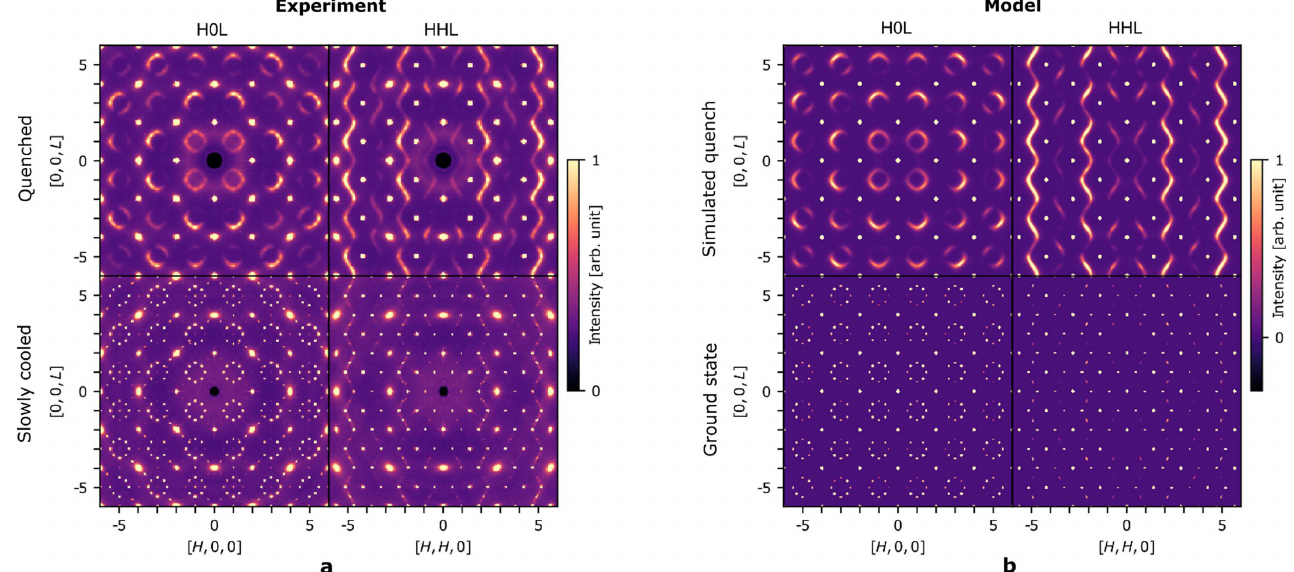
Figure 2 Measured and calculated X-ray scattering in the H0L and HHL planes. ( a ) Measured X-ray scattering from two representative samples of Nb 1 (cid:2) x CoSb at 300 K with the top row being a Q sample and the bottom row an SC sample. ( b ) Calculated X-ray scattering with the top row showing a simulated quench model, and the bottom showing a ground state of type ‘BD’ (see